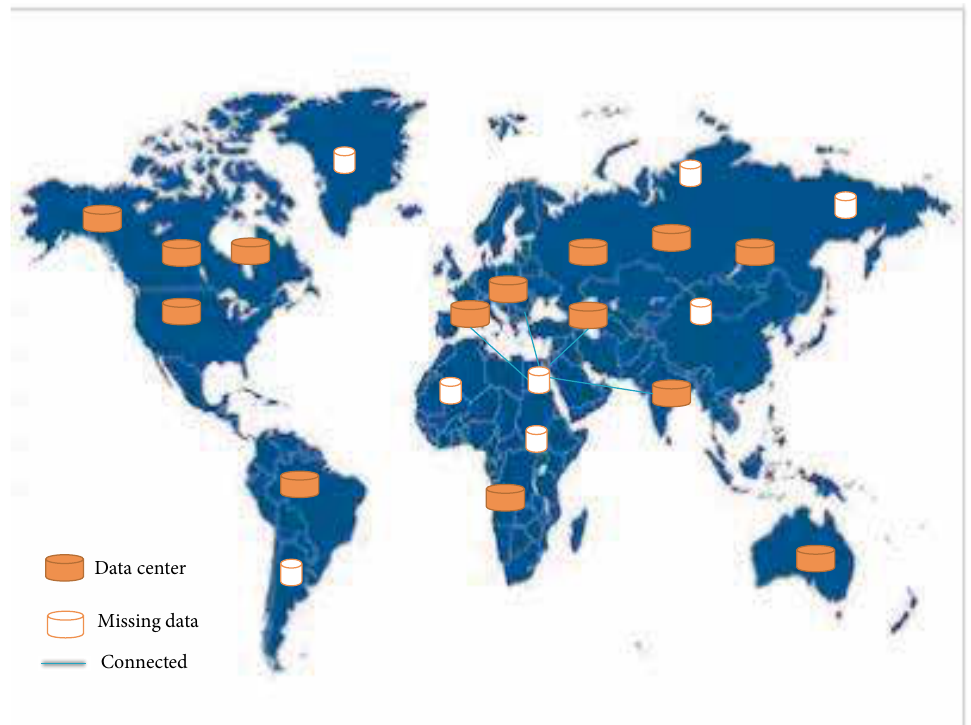
Figure 2: The concept of SSWF.